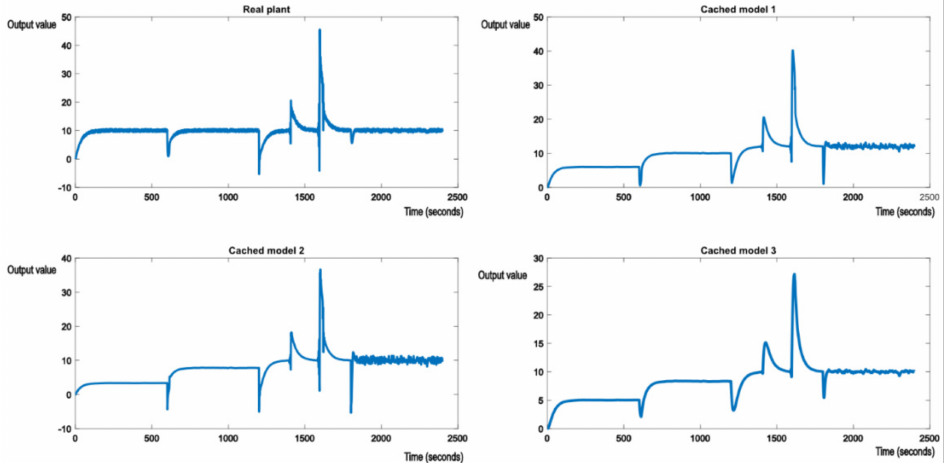
Figure 13. A series of switches between various models, mixed structural and parametric pertur- bances with noisy output measurements.